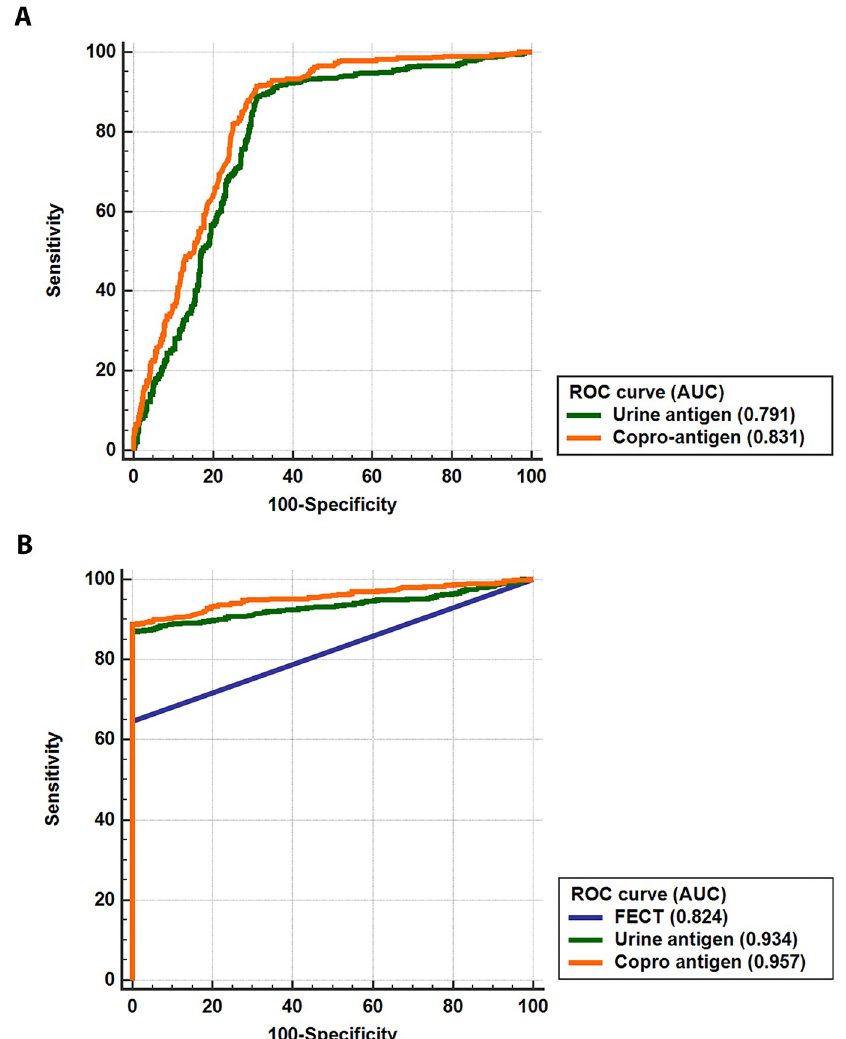
Fig 5. Receiver operating characteristic (ROC) curves comparing the antigen detection methods to the gold standard FECT (n = 1,043). (A) The ROC curve demonstrates the diagnostic performance of urine and copro-antigen detections with reference to the gold standard FECT. The AUCs of the urine and copro-antigen detection methods were 0.791 and 0.831, respectively. (B) The ROC curve shows the diagnostic performance of urine, copro-antigen detection and FECT, compared to the composite gold standard FECT which combined FECT and an antigen detection method. The AUCs for FECT, urine and copro-antigen detection and were of 0.824, 0.934 and 0.957, respectively.